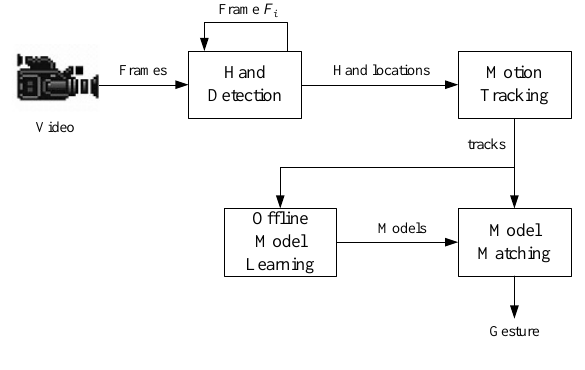
Figure 2. Framework of proposed system